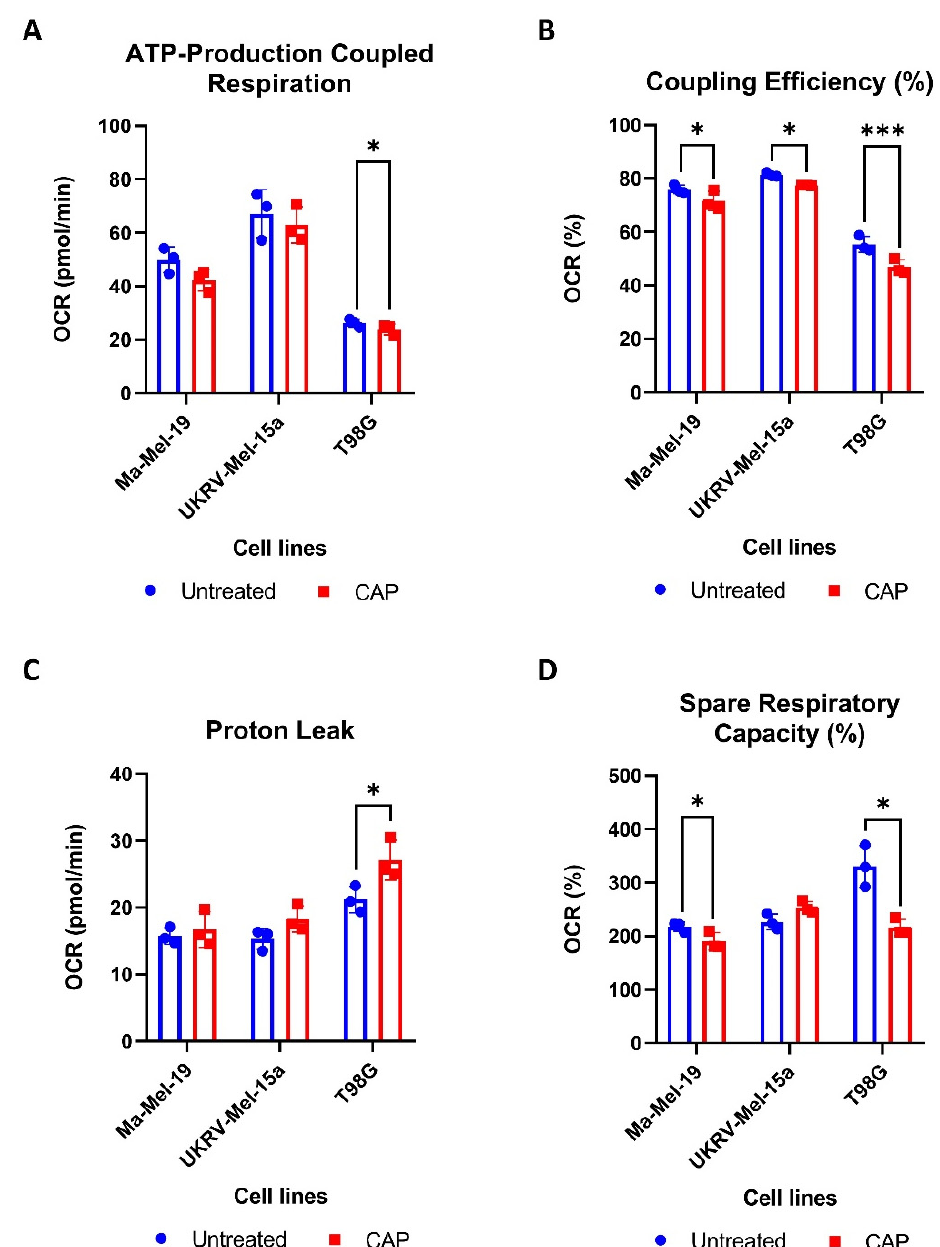
Figure 4. CAP induces mild metabolic stress in cancer cells. ( A – D ) Cancer cells were differentially treated with CAP (Ma-Mel-19—120 s CAP, UKRV-Mel-15a—60 s CAP, T98G—60 s CAP) 1 h be- fore undergoing Seahorse Cell Mito Stress Tests. The data from each of the following parameters, ( A ) ATP-production coupled respiration, ( B ) coupling efficiency (%), ( C ) proton leak, and ( D ) spare respiratory capacity (%), show the mean ± SD ( n = 3); statistical significance was calculated by per- forming paired Student’s t -tests and is indicated by the asterisks as follows: * p < 0.05; *** p < 0.001. Altogether, these results show that CAP induces mitochondrial stress in both melanoma and glioblastoma cells through the disruption of ATP production as evinced from the ob- served decreases in ATP-production coupled respiration and coupling efficiency as well as the increased proton leak following CAP treatment. It was also determined that cancer cell lines and types exhibit differing sensitives to CAP induced mitochondrial